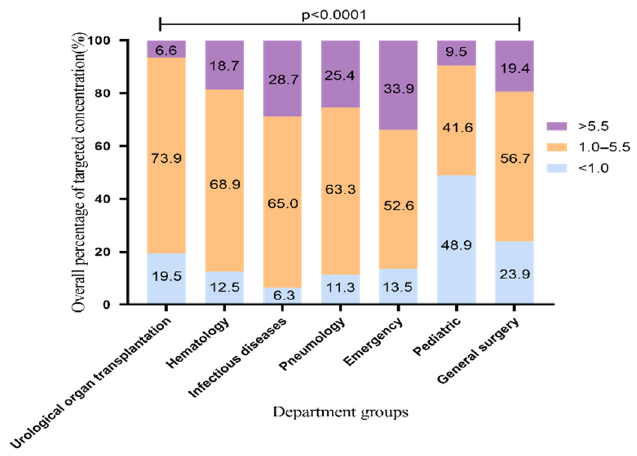
Figure 1. Overall distribution of VRZ concentration (5388 blood samples). The data represent the